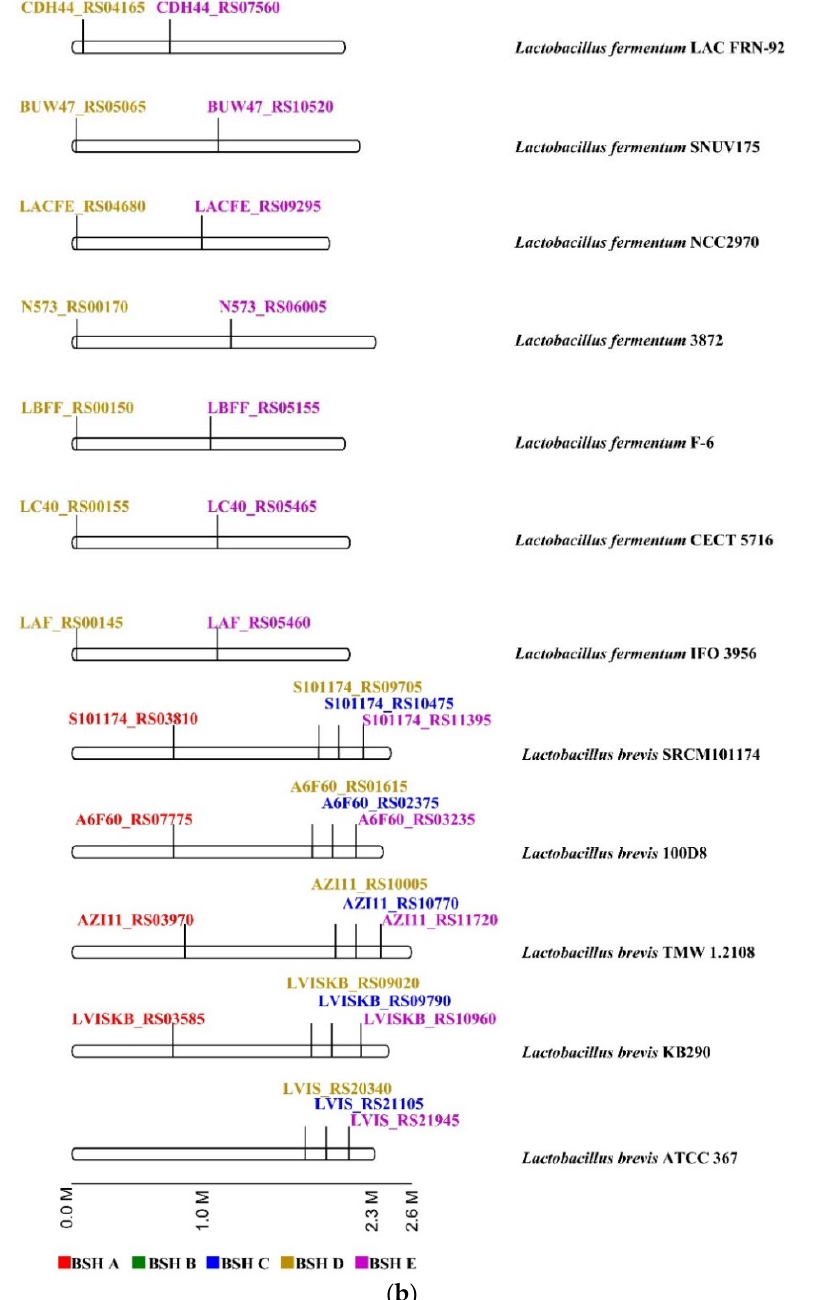
Figure 4. Distribution of BSH subtypes in 107 Lactobacillaceae species. ( a ) Proportion of each BSH subtype in 107 species. 54 species carrying BSH A or BSH B subtypes accounted for 30% in total. Group 1 consists of 16 species which have been verified for BSH activity, and is included in BSH–SDL, and the other 38 species in group 2 (10 potential cholesterol-lowering bacteria) and group 3 (28 species without related investigation) are predicted to be BSH-active based on this study; ( b ) genomic location of bsh in Lactobacillus fermentum and Lactobacillus brevis . Those colors marked on BSH subtypes ( a ) and gene ID ( b ) indicate their corresponding colors on BSH subtypes in the phylogenetic tree of Figure 2.